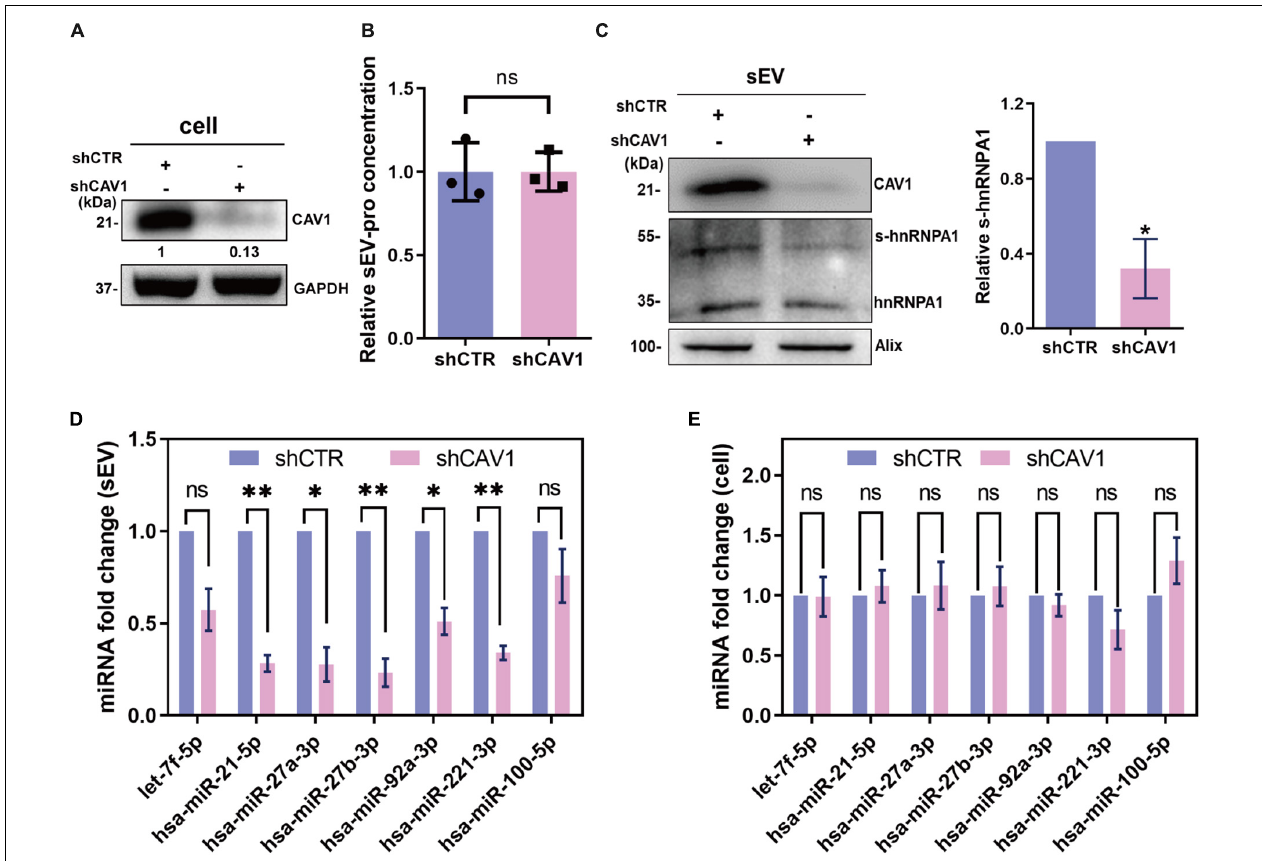
FIGURE 5 | CAV1 assists SUMOylated hnRNPA1 loading sEV-miRNA. (A) CAV1 protein level in shCAV1 cells. (B) Protein concentration of sEVs derived from shCAV1 and control cells. (C) CAV1 and hnRNPA1 protein levels in sEVs derived from shCAV1 cells (left). Statistical analysis showing the ratio of SUMOylated hnRNPA1 and hnRNPA1 in three independent assays (right). Relative expression level of the selected miRNAs in sEVs (D) and shCAV1 cells (E) . Statistically significant differences are reported for three independent experiments (ns, no significance; ∗ p < 0.05; ∗∗ p < 0.01, two-tailed t -test). CAV1, caveolin-1; hnRNPA1, heterogeneous nuclear ribonucleoprotein A1; sEV-miRNA, microRNA in small extracellular